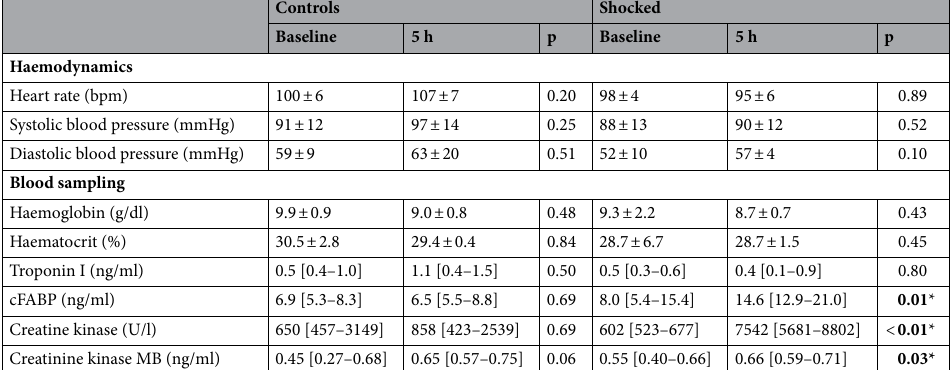
Table 1. Haemodynamics and blood samples. Mean ± SD or median [interquartile range] demonstrate haemodynamics and fluid status were maintained to a consistent level from baseline to the 5 h timepoint for each group, while the majority of serology markers increased in the shocked group only. *p < 0.05 represents a significant difference between baseline and 5 h measures. cFABP porcine cardiac fatty acid binding protein. Significant values are in bold.